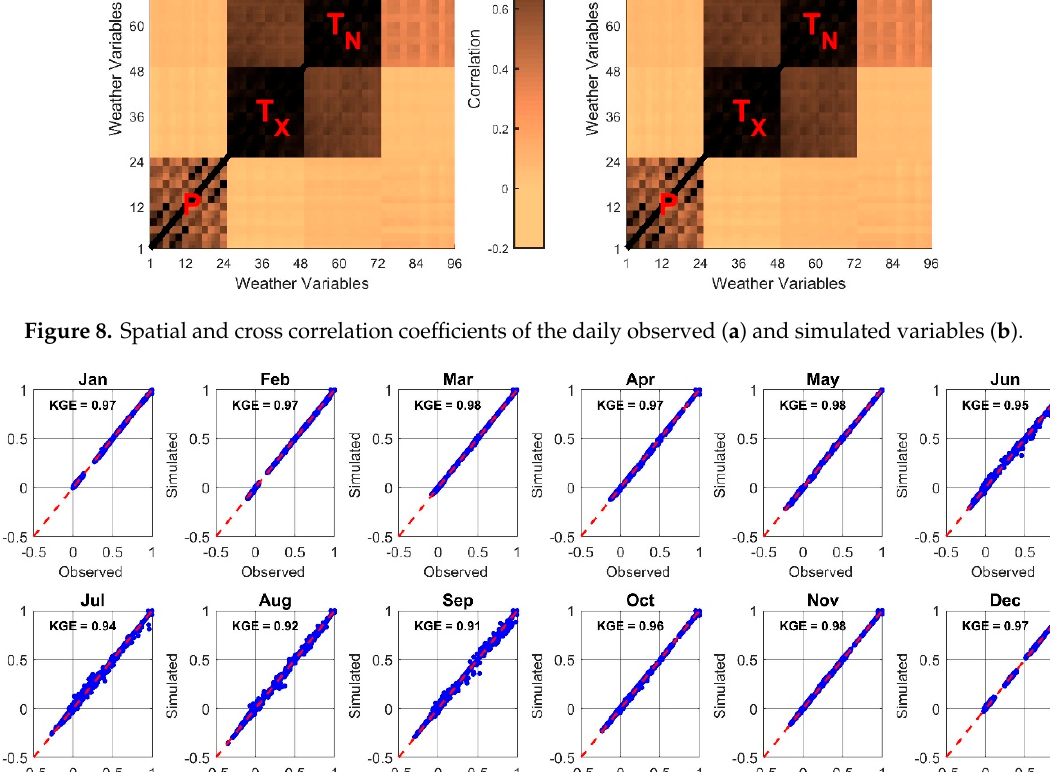
Figure 10. Lag-1 day auto-correlations of the weather variables T x , T N , and WS, respectively, for all months. The results presented here glimpse the model capability to preserve the statistical properties of the observations to synthesize the future scenarios. The proposed model demonstrated the Wilks technique ability to generate anomalies similarly to the observations. It is also seen that the hybrid